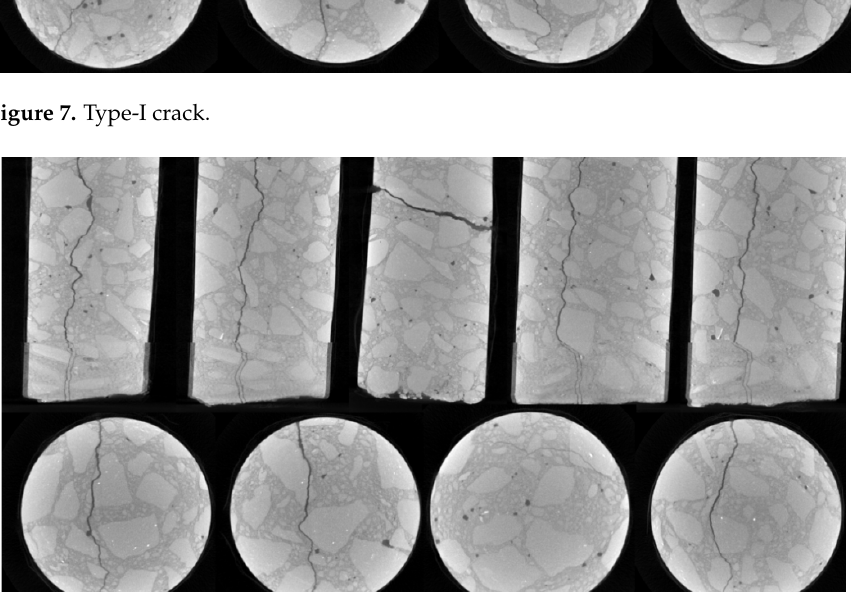
Figure 8. Type-II crack .